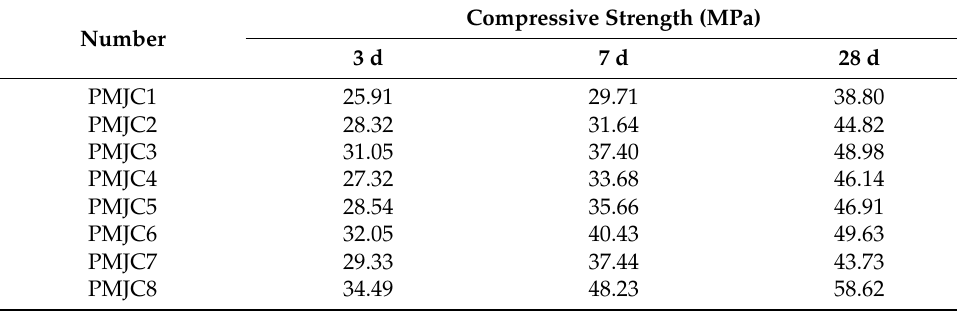
Table 7. Results of the cube compressive strength